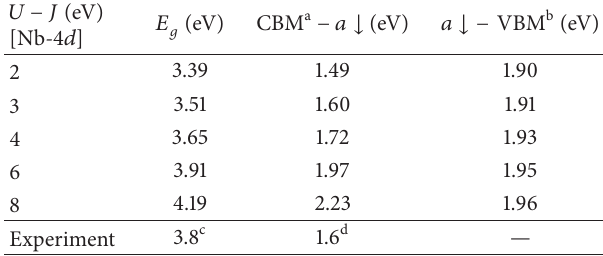
Table 2: Parameters of the electronic band structures at the Γ point calculated for the Fe 2+ Li -LiNbO 3 cell within the LSDA + 𝑈 approach with various 𝑈 − 𝐽 terms of Nb-4 d (the 𝑈 − 𝐽 value of Fe-3 d is fixed to be 4eV). The value of band gap ( 𝐸 𝑔 ) accords with the energy difference between the CBM and the